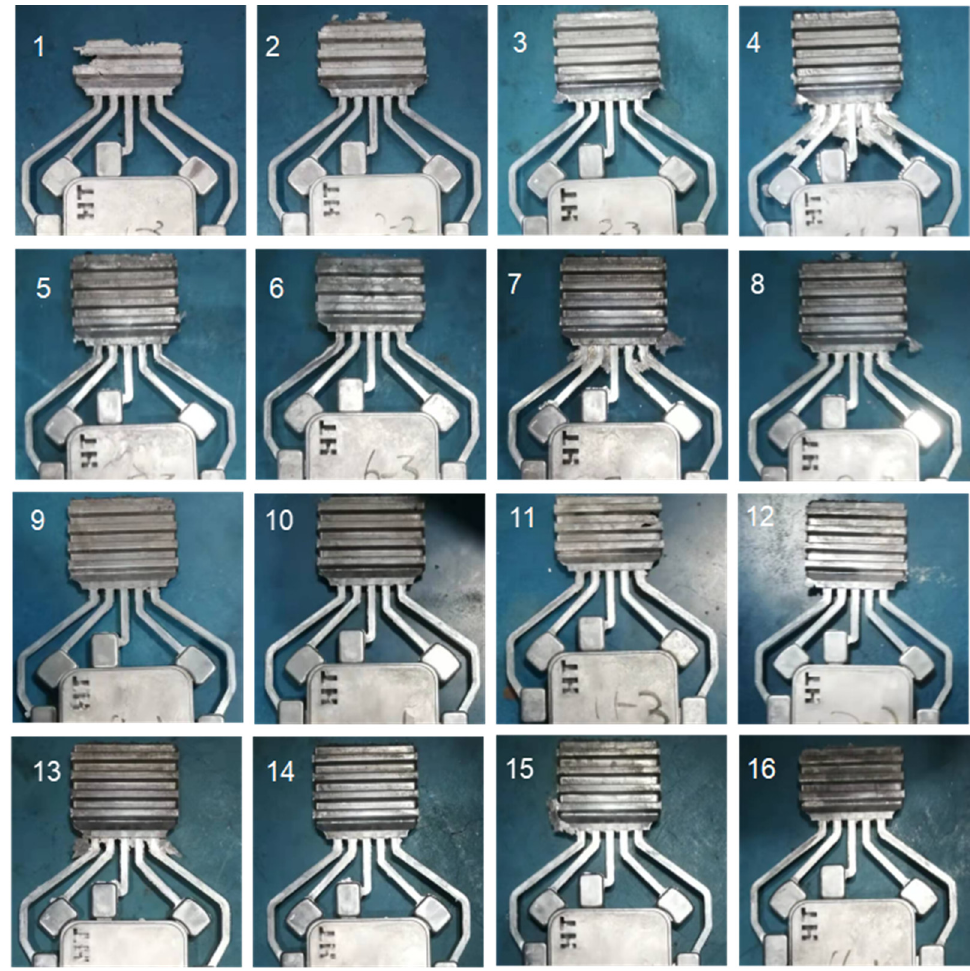
Figure 10. Filling capacity of a chill vent under different process conditions (The number in Figure is corresponding to the Test No.). Table 4. The process plan and results of orthogonal